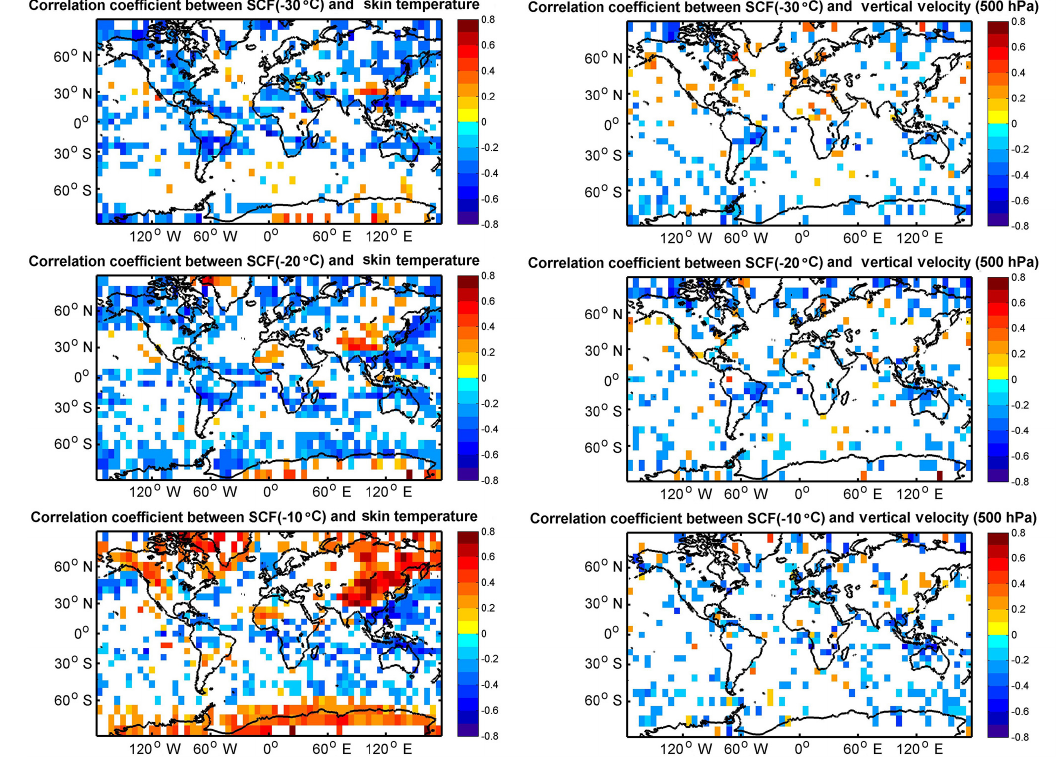
Figure 5. Temporal correlations (at the 90% confidence level) between SCFs at three isotherms and skin temperature (left panel) and vertical velocity at 500hPa (right panel). The correlations are based on 96 months’ monthly SCFs and meteorological parameters. Grid size is 6 ◦ latitude by 6 ◦